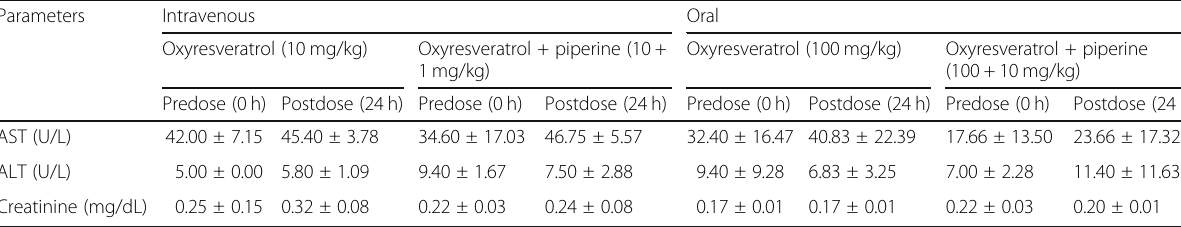
Table 1 Tolerability of oxyresveratrol alone and in combination with piperine Parameters